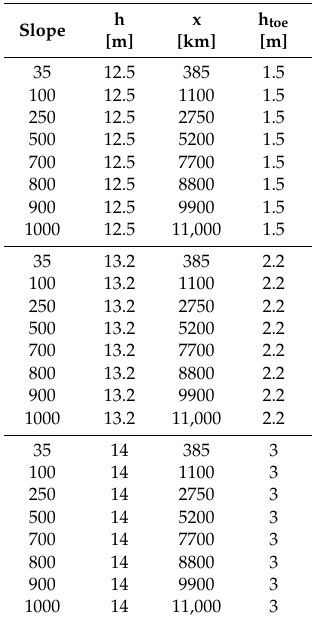
Table 2. SWASH input data for di ff erent slopes and water depths (no structure).